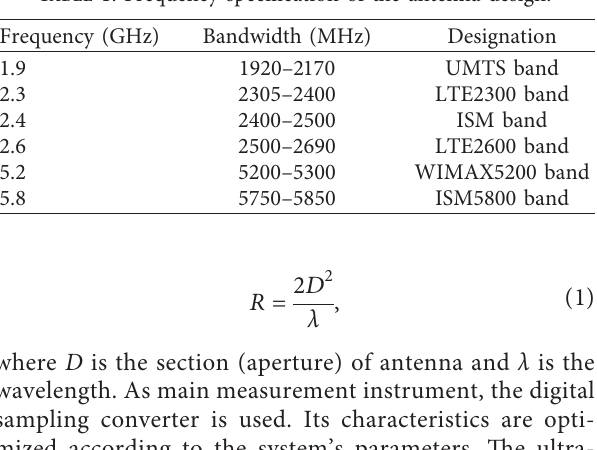
Table 1: Frequency specification of the antenna